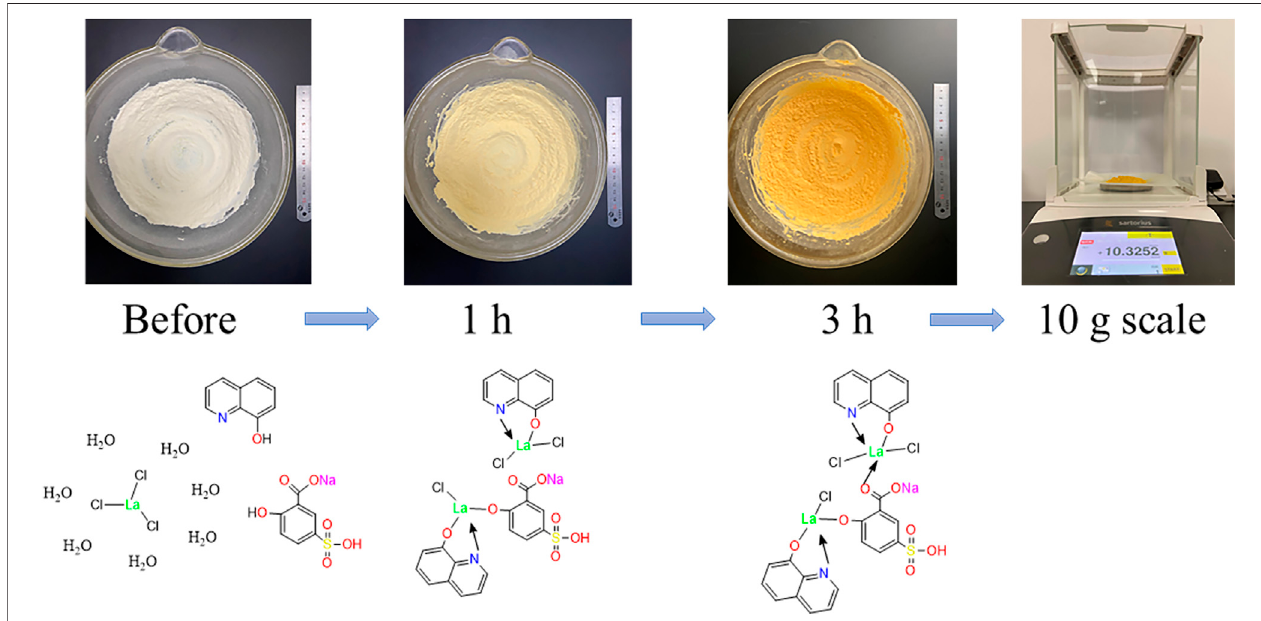
FIGURE 1 | Preparation of 10-gram-scale ternary lanthanum CPs and its possible coordination bonds in the structure